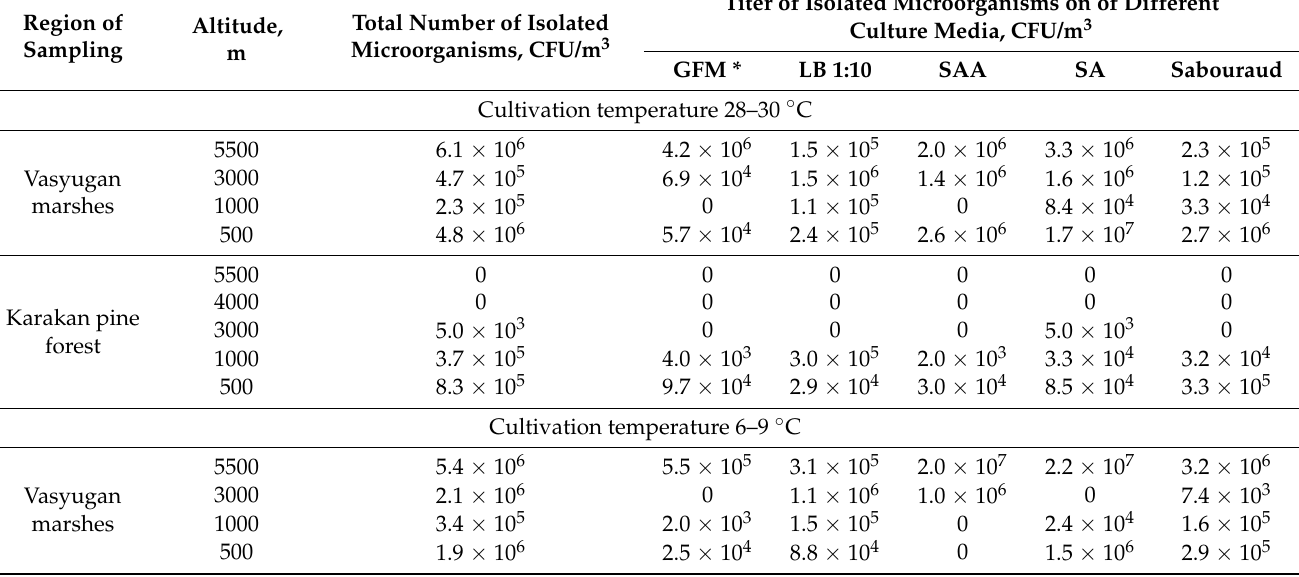
Table 2. The concentration of culturable microorganisms in the studied samples of atmospheric aerosols. Region of Sampling